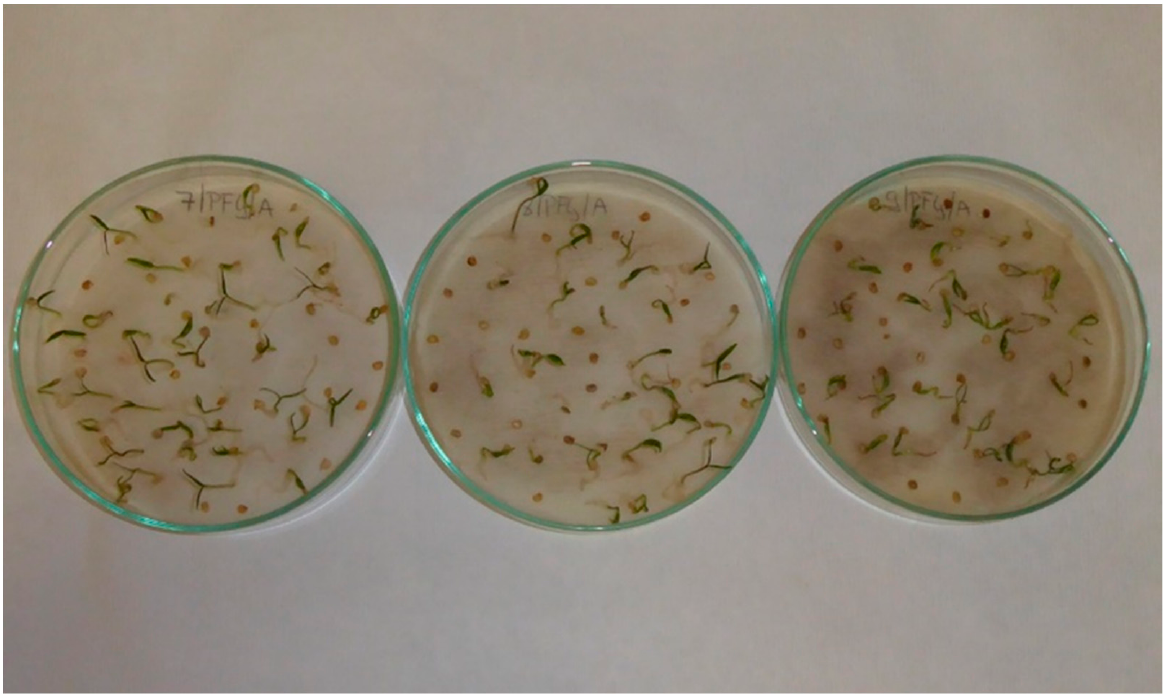
Figure A2. Pepper ( Capsicum anuum L.) seedlings; treatments with aqueous extracts of black cumin ( Nigella sativa L.) in 2.5% concentration ( left ), 5% concentration ( middle ) and 10% concentration ( right ).